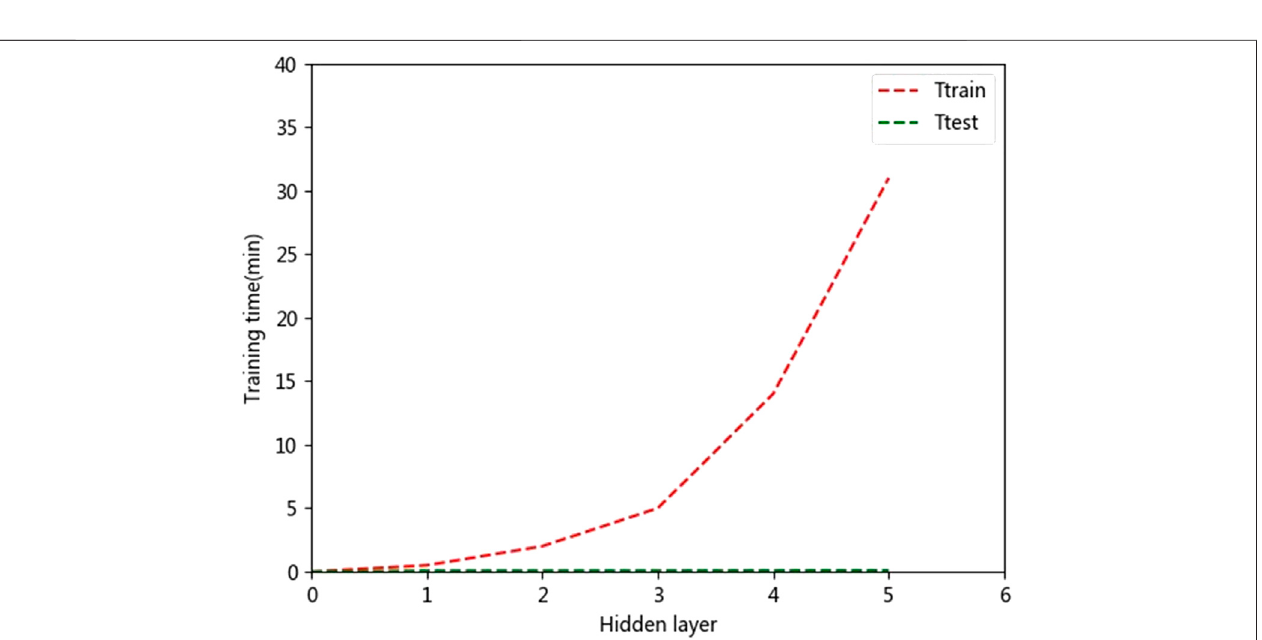
FIGURE 7 | Model training time with different hidden layers of gene